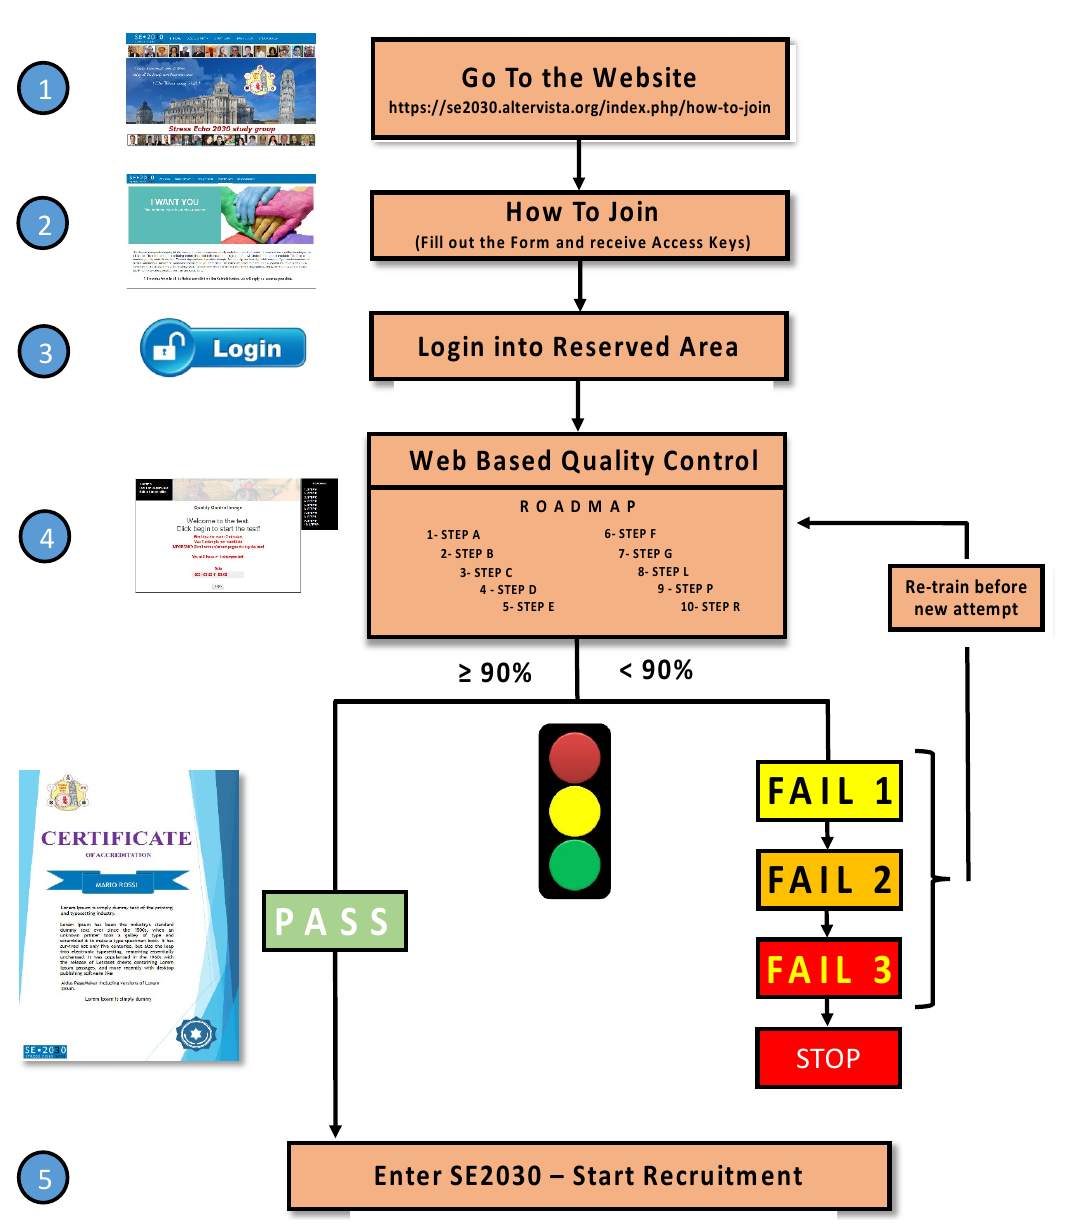
Figure 1. Stress echo 2030: road to accreditation.